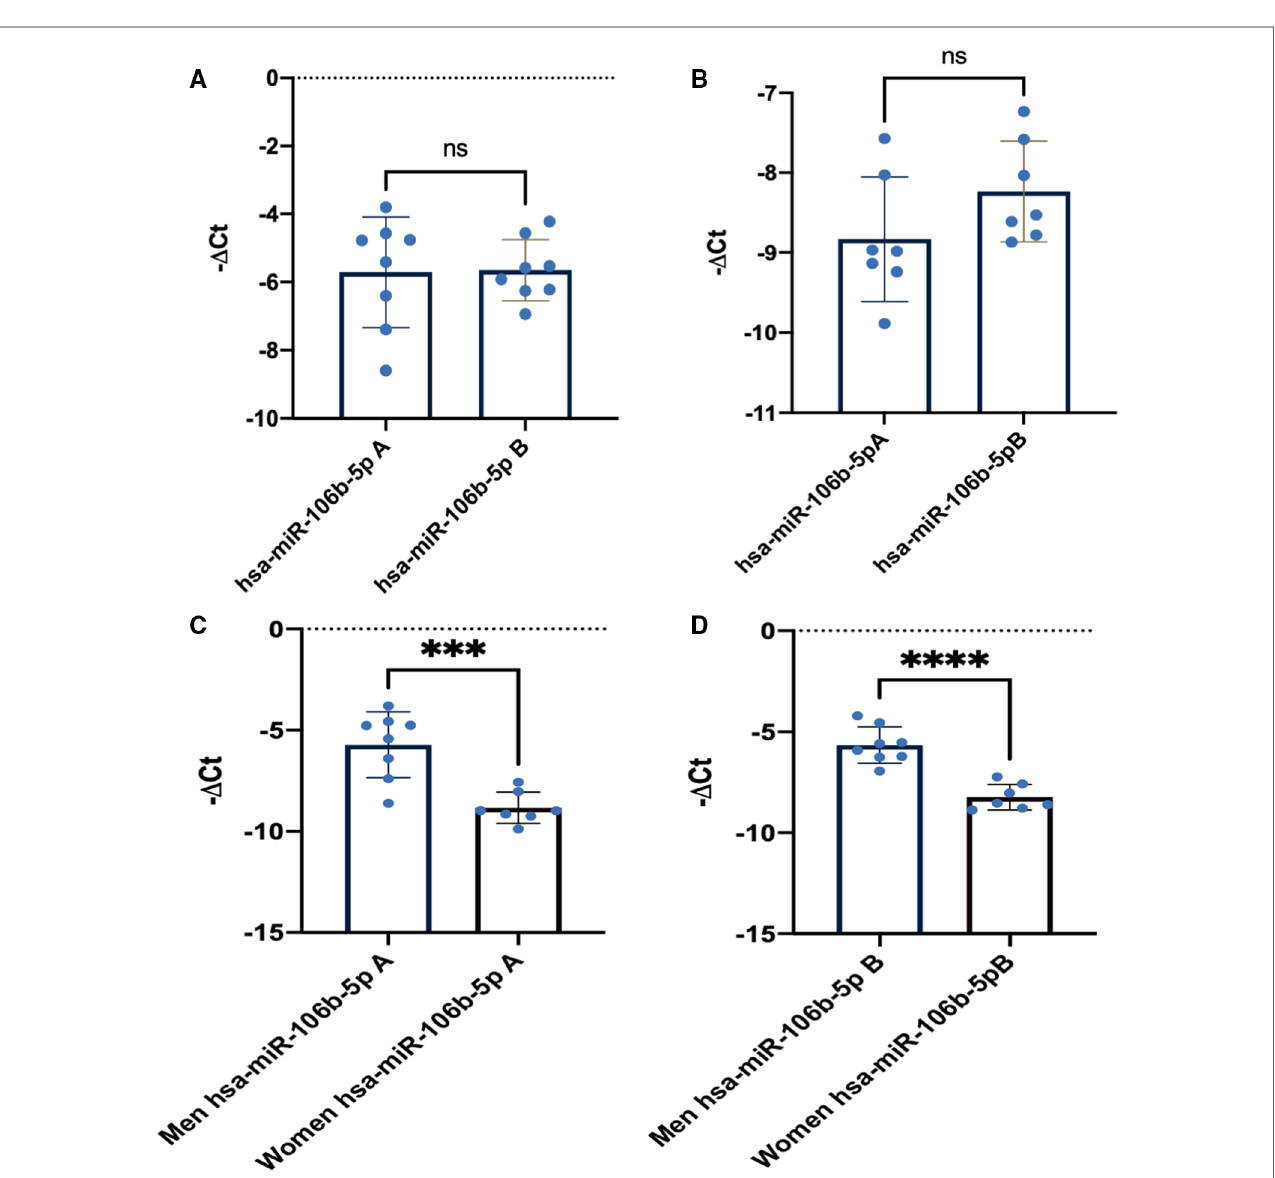
FIGURE 1 miR-106b-5p training response in men and women. ( A ) Mir-106b-5p men athletes ’ response at point A and B. ( B ) MiR-106b-5p women athletes ’ response at point A and B. ( C ) Men vs. women comparison at point A. ( D ) Men vs. women comparison at point B. Data are presented as means, single values and SD. Ns, nonsigni fi cant changes A –